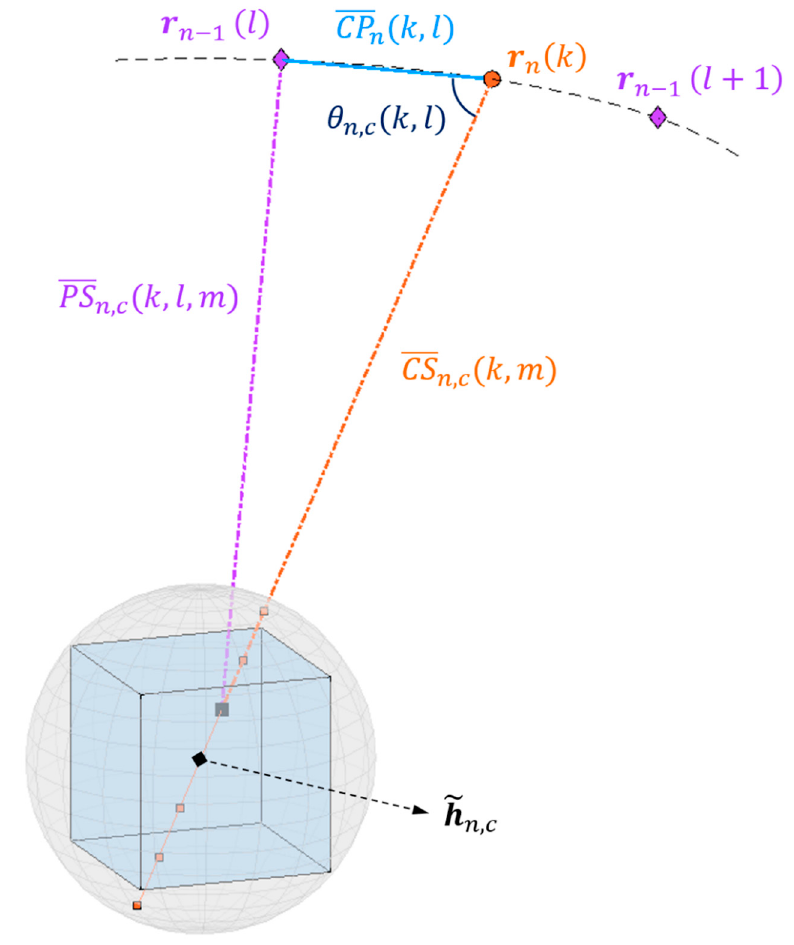
Figure 6. Range samples at a child subimage and geometry for calculating distances between a range sample, a child subaperture, and a parent subaperture.